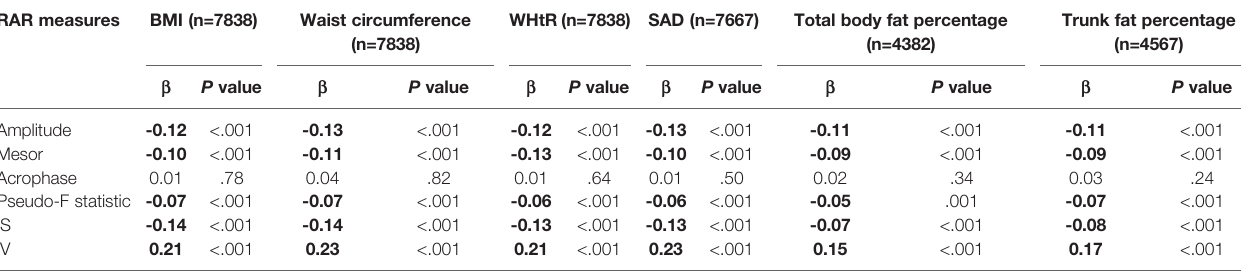
TABLE 2 | Multivariable linear regression results of the association between RAR metrics and obesity measures. RAR measures